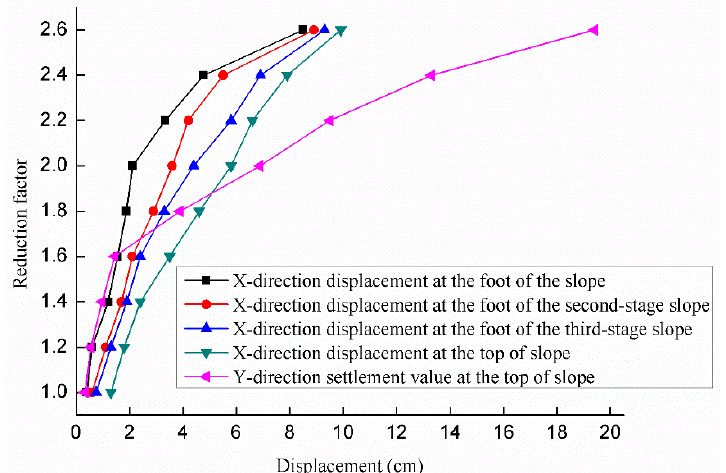
Figure 5. X-direction and Y-direction displacements of the protective slope with a changed reduction factor.